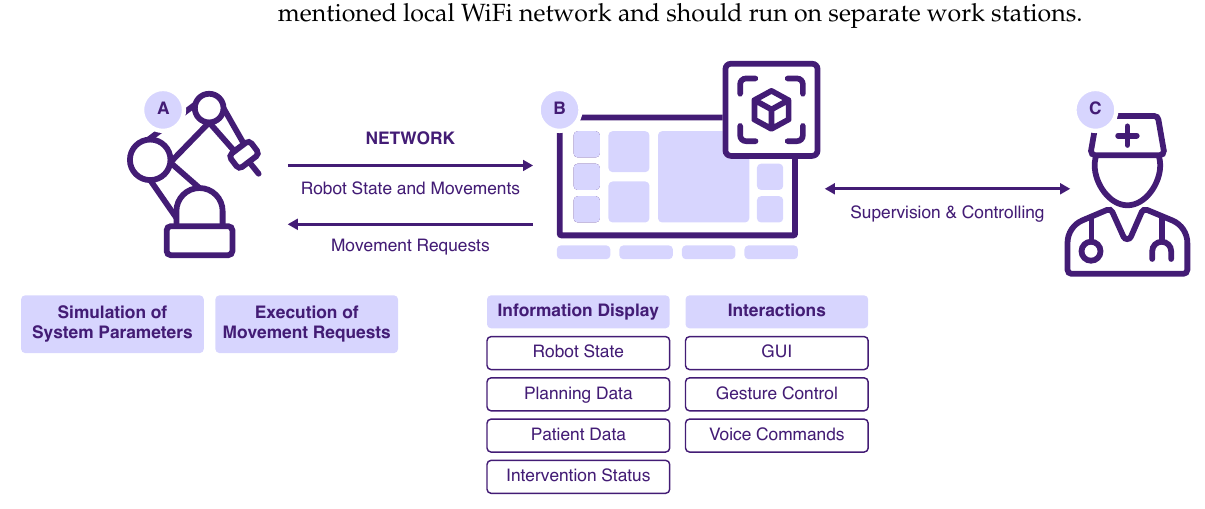
Figure 5. System overview of the developed prototype: Robot ( A ), AR System ( B ) and User ( C ).